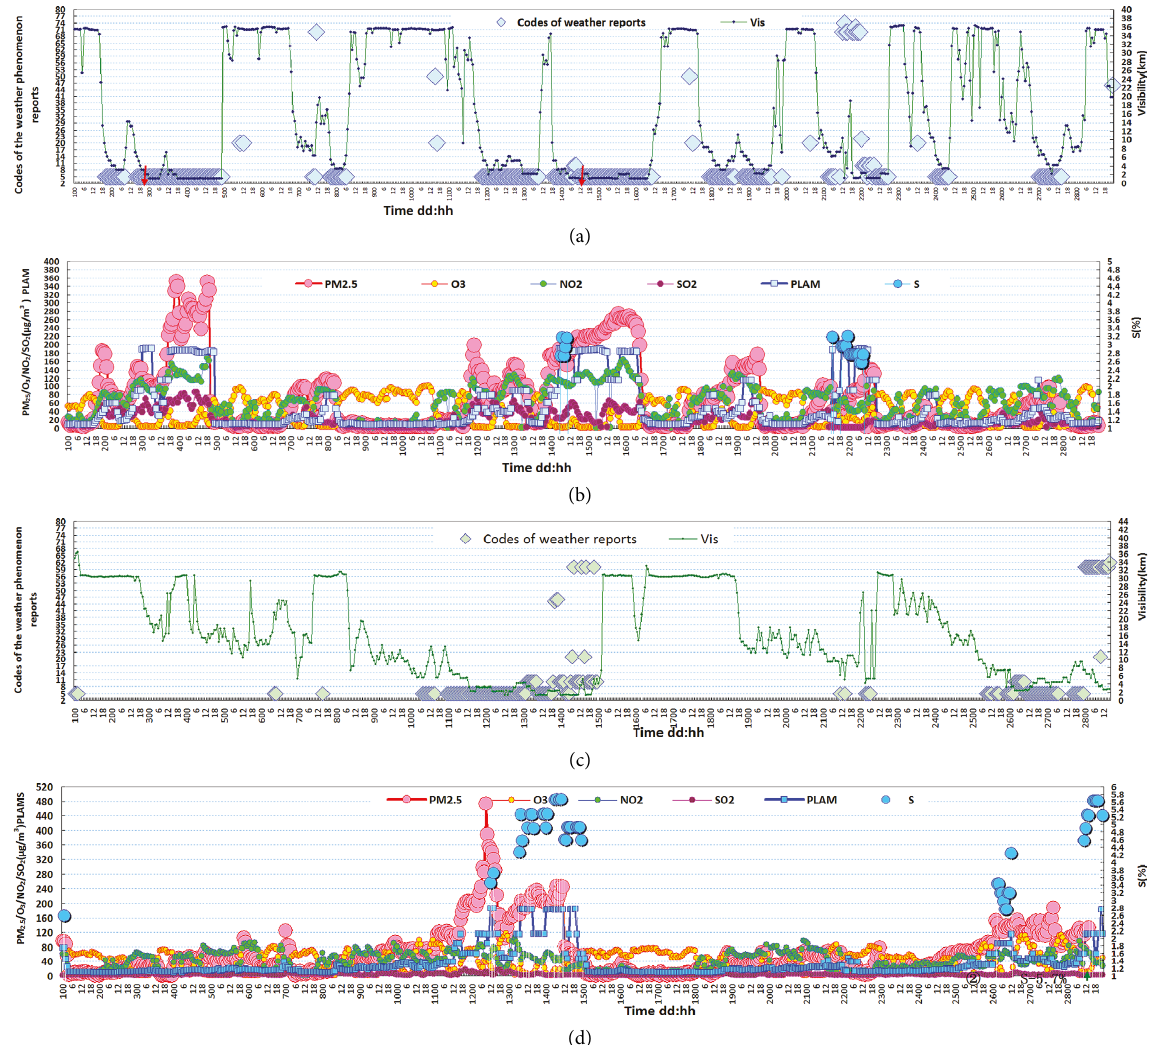
Figure 3: Hourly distributions of visibility (VIS) and fog–haze in Beijing for February 1–28, 2017 (a) and (c) 2021; hourly observed distributions of PM 2.5 , O 3 , NO 2 , SO 2 , the PLAM index, and low-layer atmospheric supersaturation (S) for February 1–28, (b) 2017 and (d)